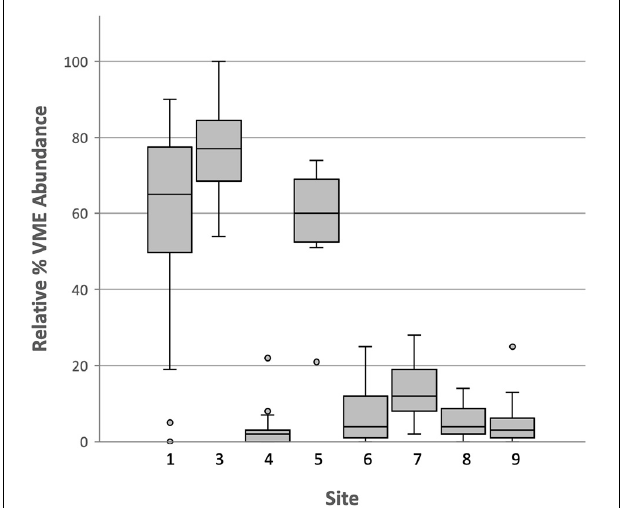
FIGURE 9 | Boxplot of all VME indicator taxa relative abundance data across dive